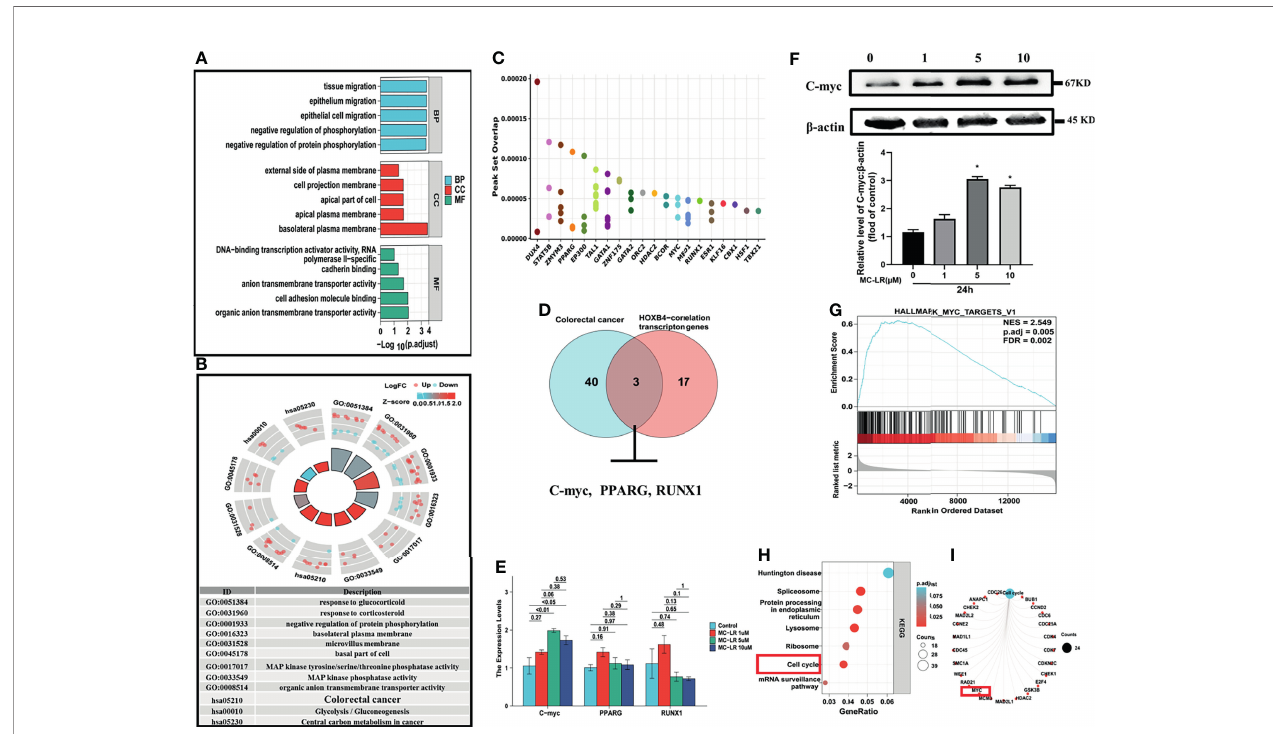
FIGURE 7 | Cell cycle progression promoted by MC-LR-induced HOXB4 expression up-regulation. (A) GO enrichment analysis results of DEGs. (B) KEGG pathway analysis results of DEGs. (C) Top 20 genes overlapping in HOXB4 and the HOXB4-correction transcription genes by Cistrome. (D) Venn diagram of the genes involved in the colorectal cancer pathways and the top 20 genes in the HOXB4-correlation transcription genes. (E) mRNA expression levels of C-myc, PPARG and RUNX1 in Caco2 cells treated with 1, 5 and 10 m M MC-LR for 24h n=3. (F) Representative immunoblot images and quanti fi cation of C-myc in Caco2 cells treated with MC-LR for 24h n=3. (G) Gene Set Enrichment Analysis (GSEA) for the potential altered pathways in the MC-LR-treated and Control groups. (H, I) KEGG enrichment analyses of the HOXB4-regulated genes. * P <0.05 vs. the untreated cells. DEGs, differentially expressed genes; GO, Gene Ontology; BP, biological process; CC, cellular component; MF, molecular